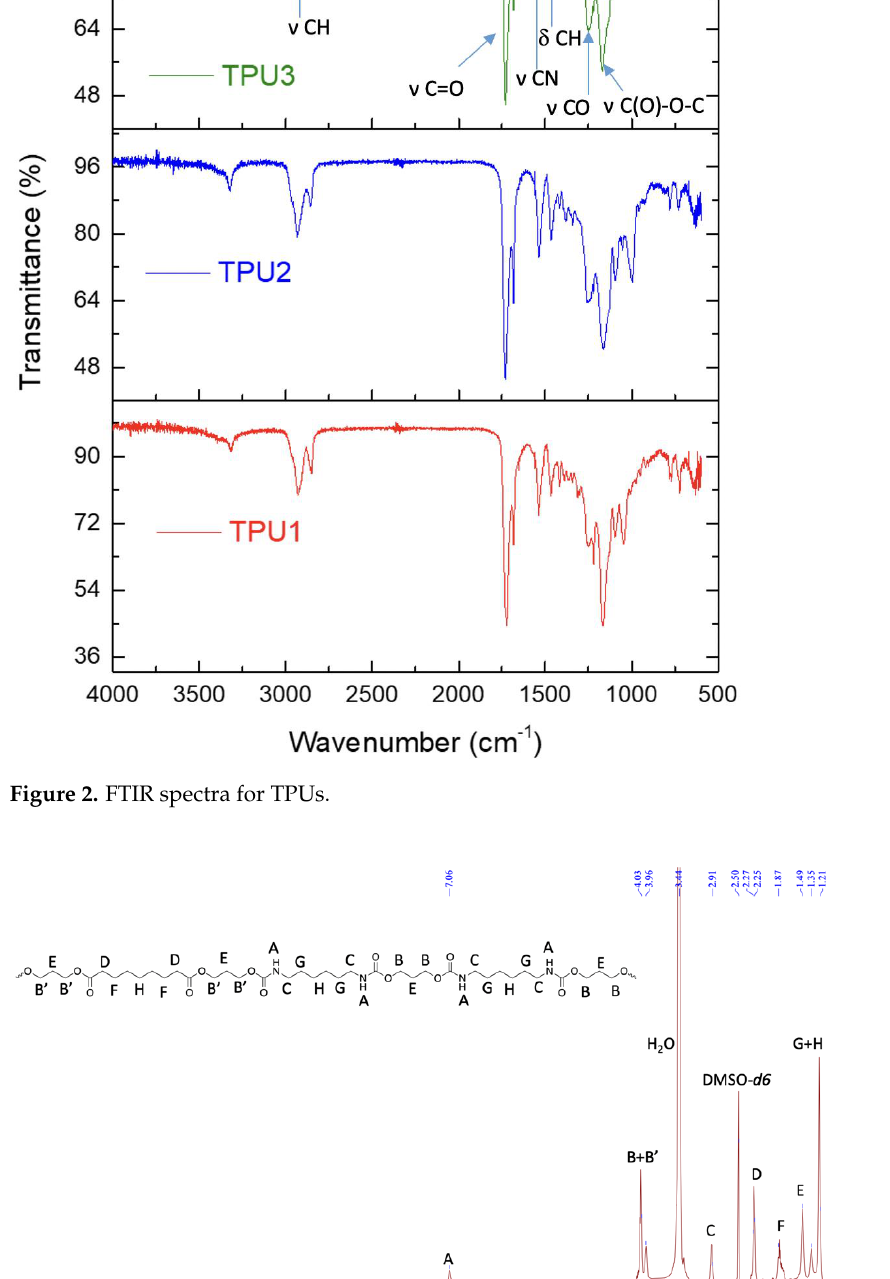
Figure 3. 1 HNMR of TPU1 in DMSO- d6 (500 MHz, 298 K).